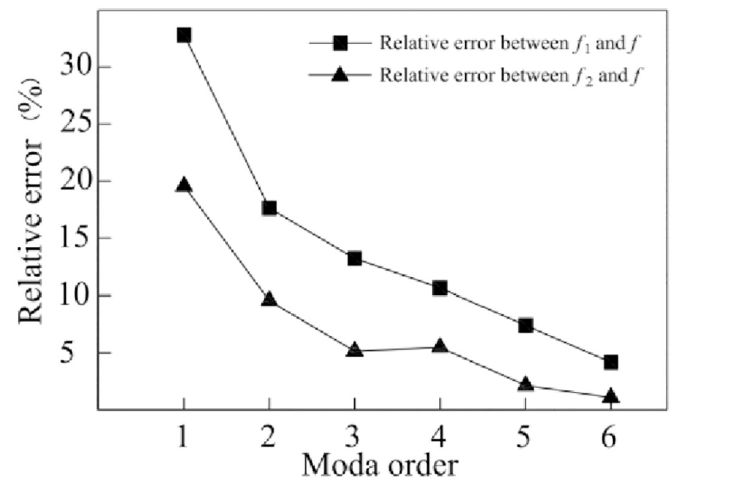
Fig 7. Relative error between simulation result and test